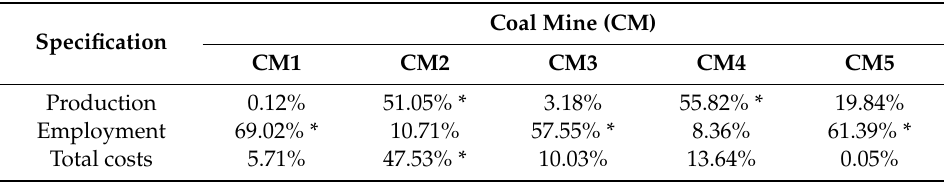
Table 3. Determination coe ffi cients ( ϕ 2 ) between labor productivity and production volume, employment, and total